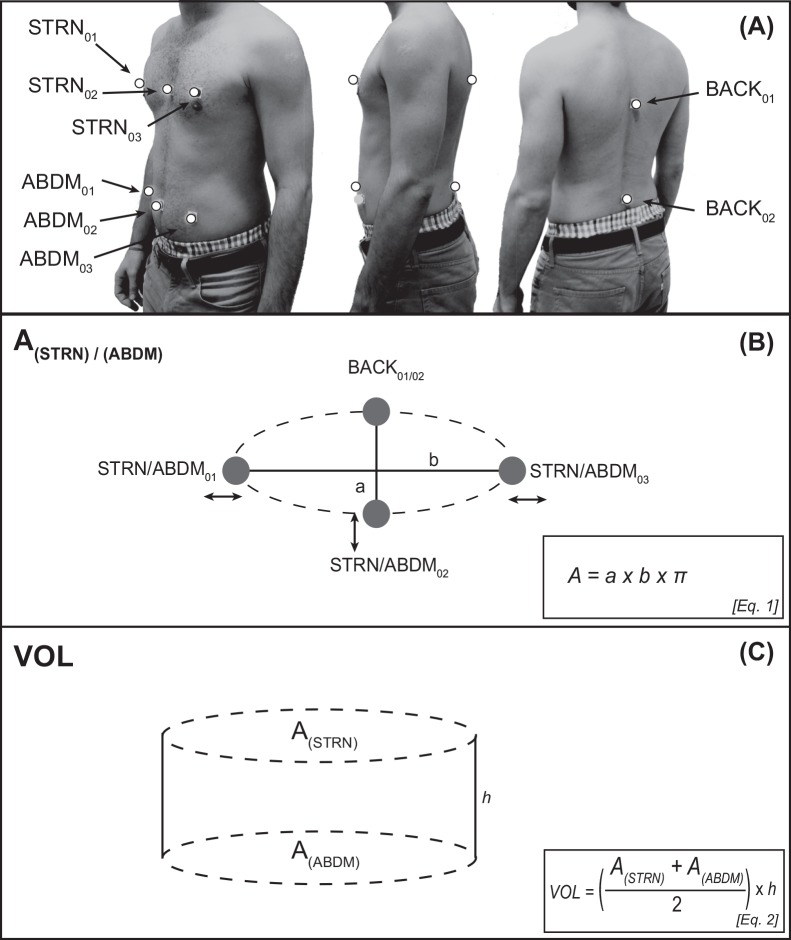
Marker setup and theoretical approach to calculate subjects’ ventilation.Fig 1A shows marker placements (white dots) used in the experiments in frontal, lateral and rear view. Fig 1B displays the theoretical approach used to calculate subjects’ chest volume. Surface areas of the thoracic and abdominal portion were calculated separately according to Eq. 1, and Fig 1C shows the calculation of a cylinder using Eq. 2 that closely matched subjects’ chest volume.